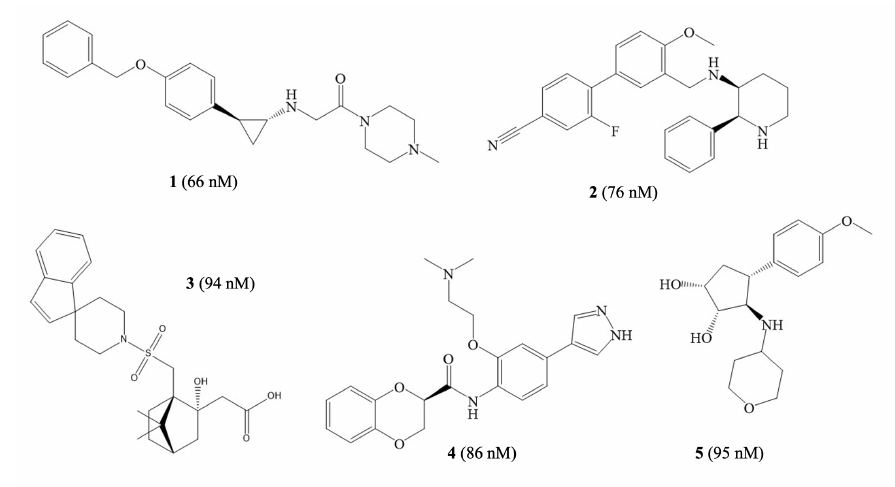
Figure 6. Structures and predicted IC 50 values (in parentheses) of five molecules produced from the virtual screening: 1 (ZINC000098052700), 2 (ZINC000022449627), 3 (ZINC000038942511), 4 (ZINC000040414461), and 5